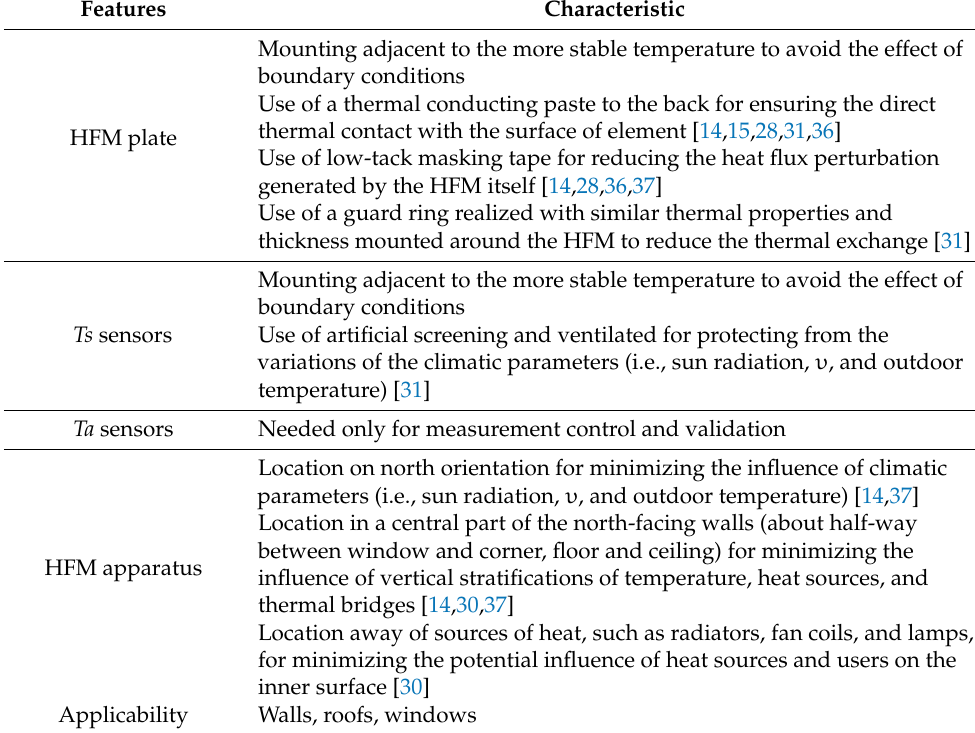
Table 6. Location of the HFM apparatus (source: authors’